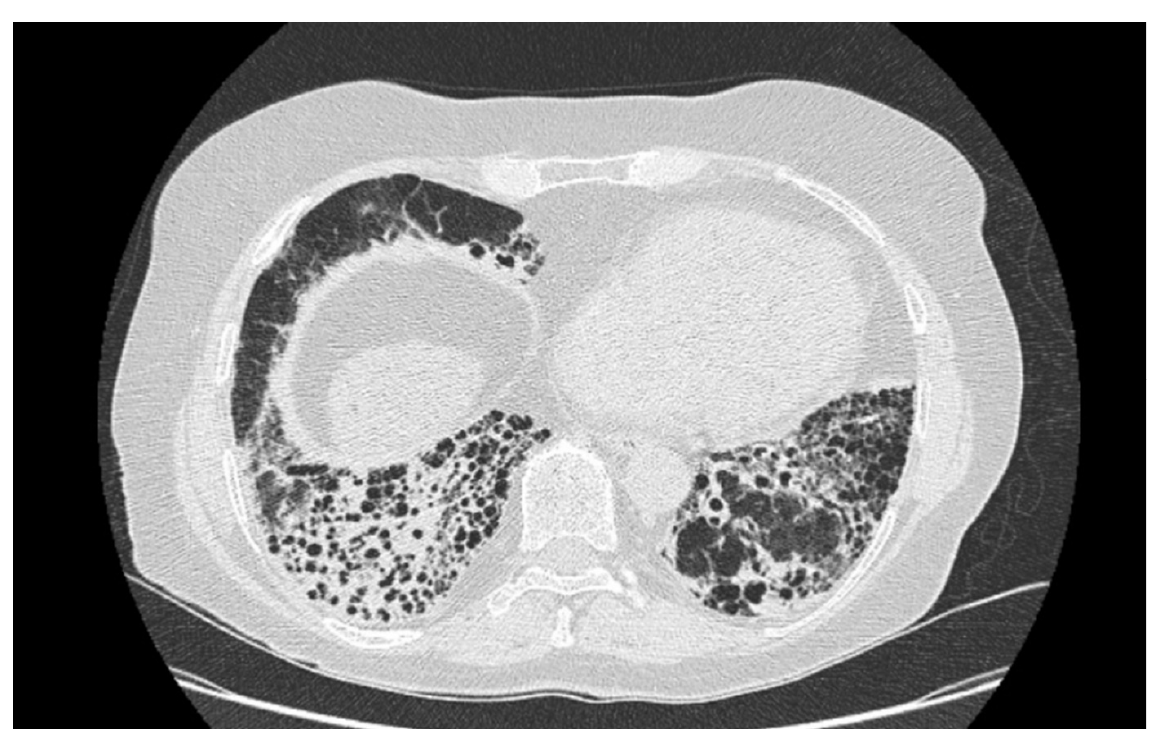
Figure 2. UIP in course of SSc-ILD.